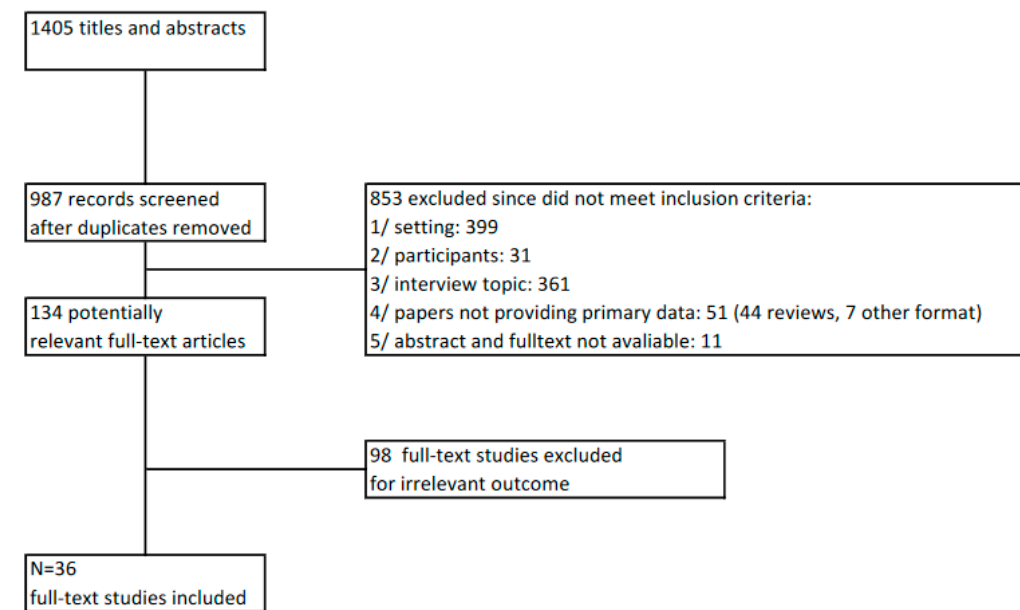
Figure 1. Preferred Reporting Items for Systematic Review and Meta-analysis (PRISMA) diagram.